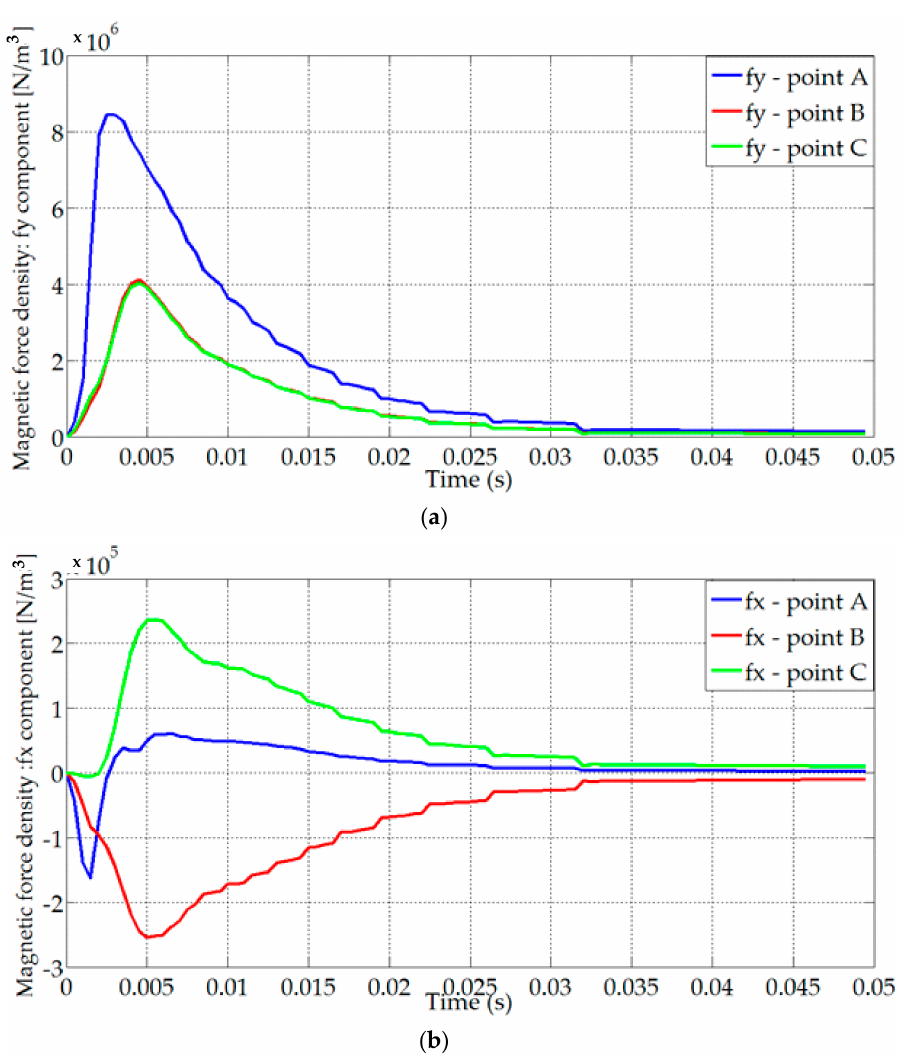
Figure 9. Maximum volume magnetic force density on the plate in non-linear magnetic and conductive VACOFER S1 material: ( a ) f y -components, ( b ) f x